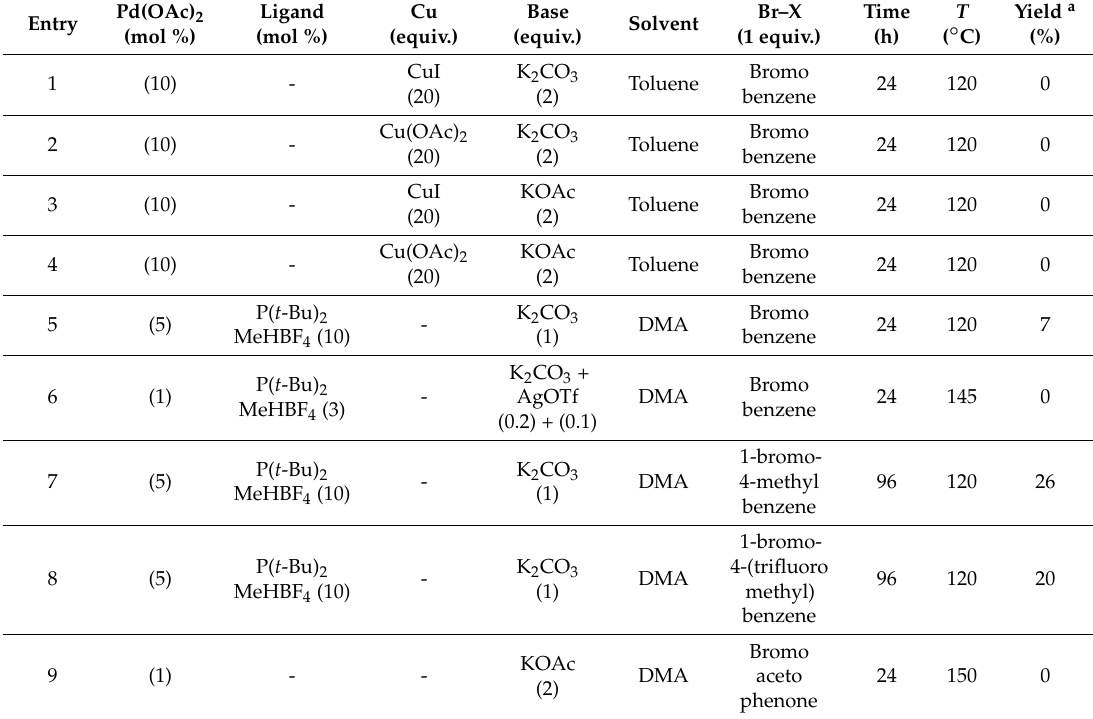
Table 1. Optimization of direct C–H arylation in position 3 of the 2-phenylthieno[3,2- b ]pyridine